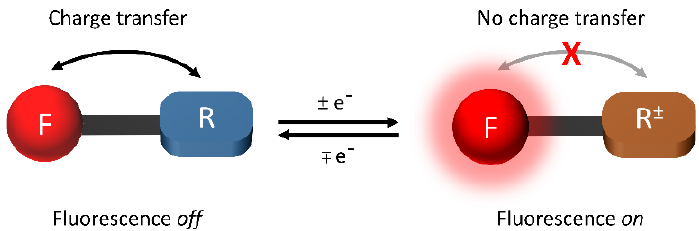
Figure 5. General structure of intrinsic fluorophore (F) covalently coupled with an electroactive component (R) of a molecular dyad and the intramolecular charge exchange mechanism that is responsible for electrochemically mediating fluorescence intensity modulation.